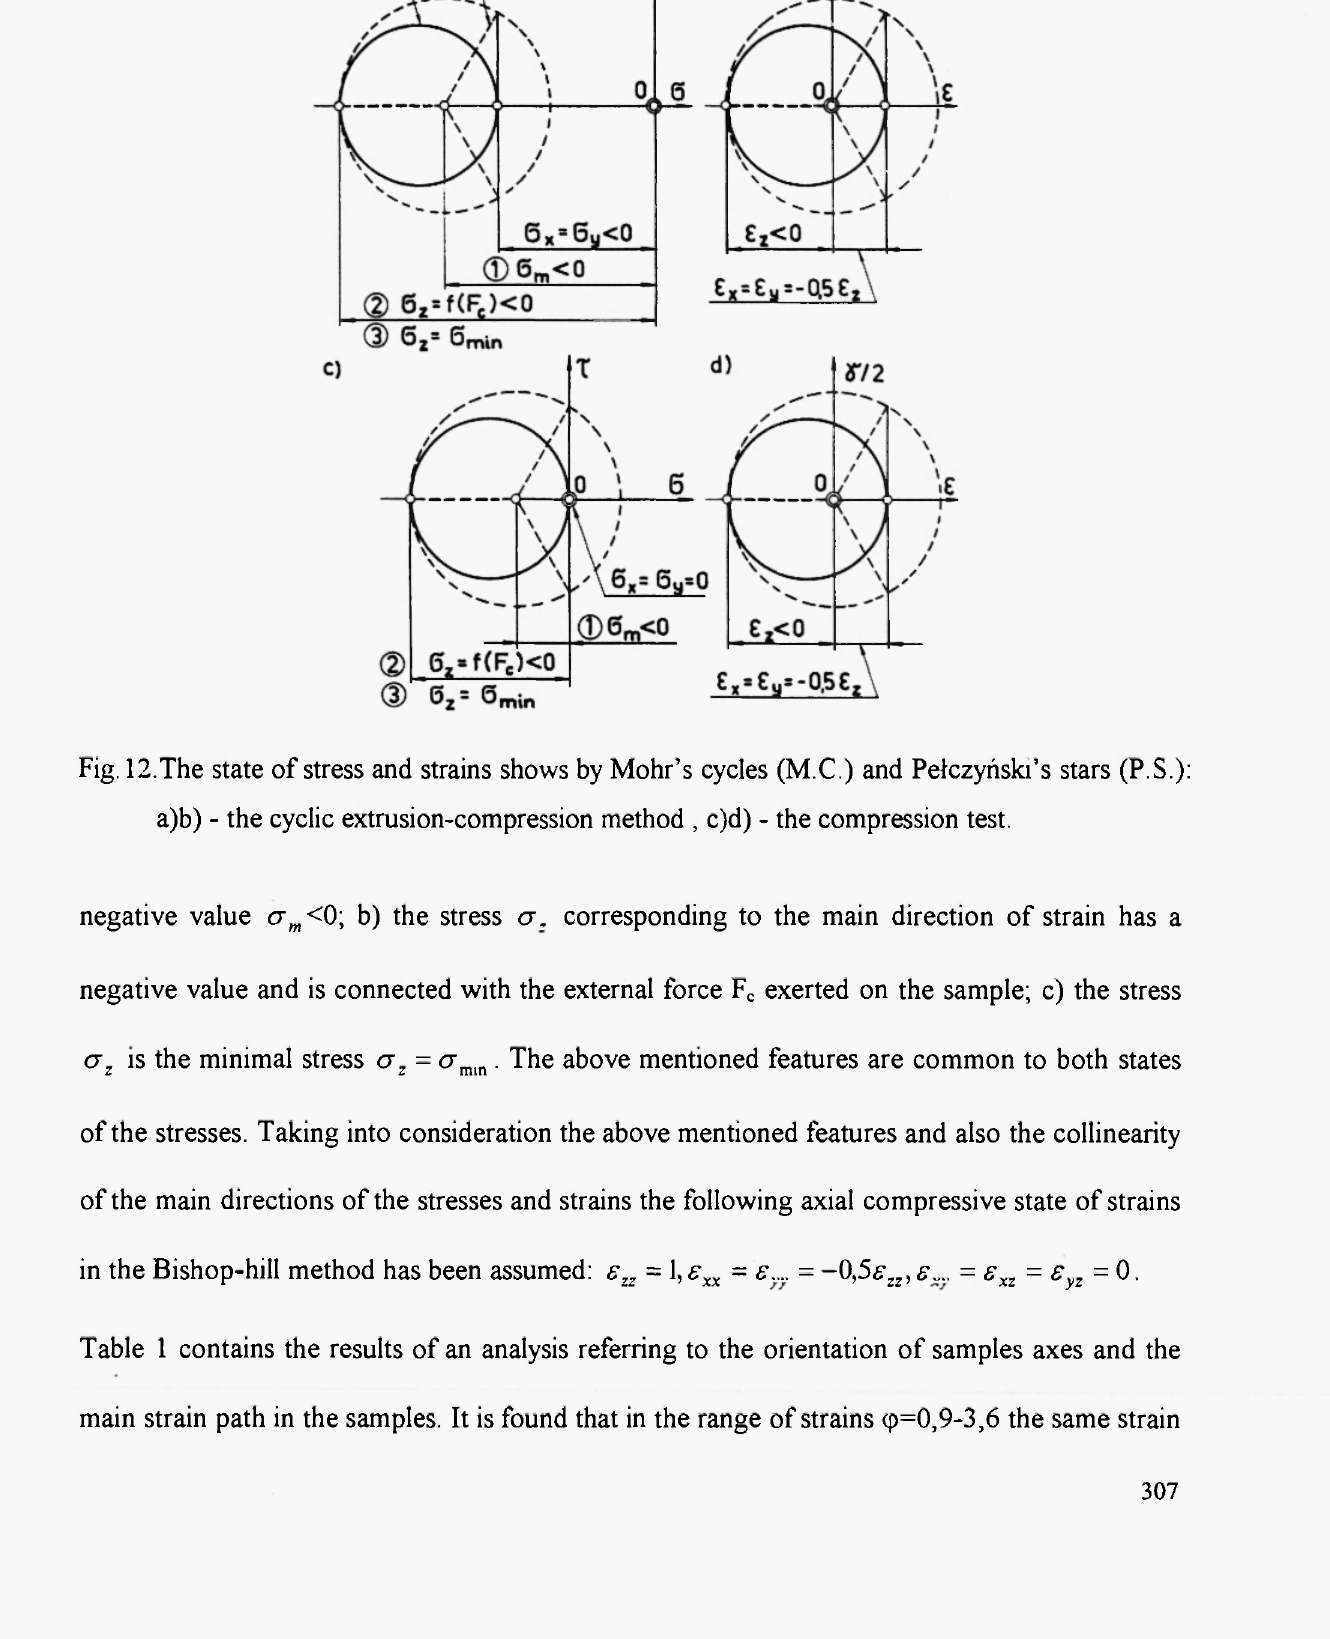
Table 1 contains the results of an analysis referring to the orientation of samples axes and the main strain path in the samples. It is found that in the range of strains φ=0,9-3,6 the same strain